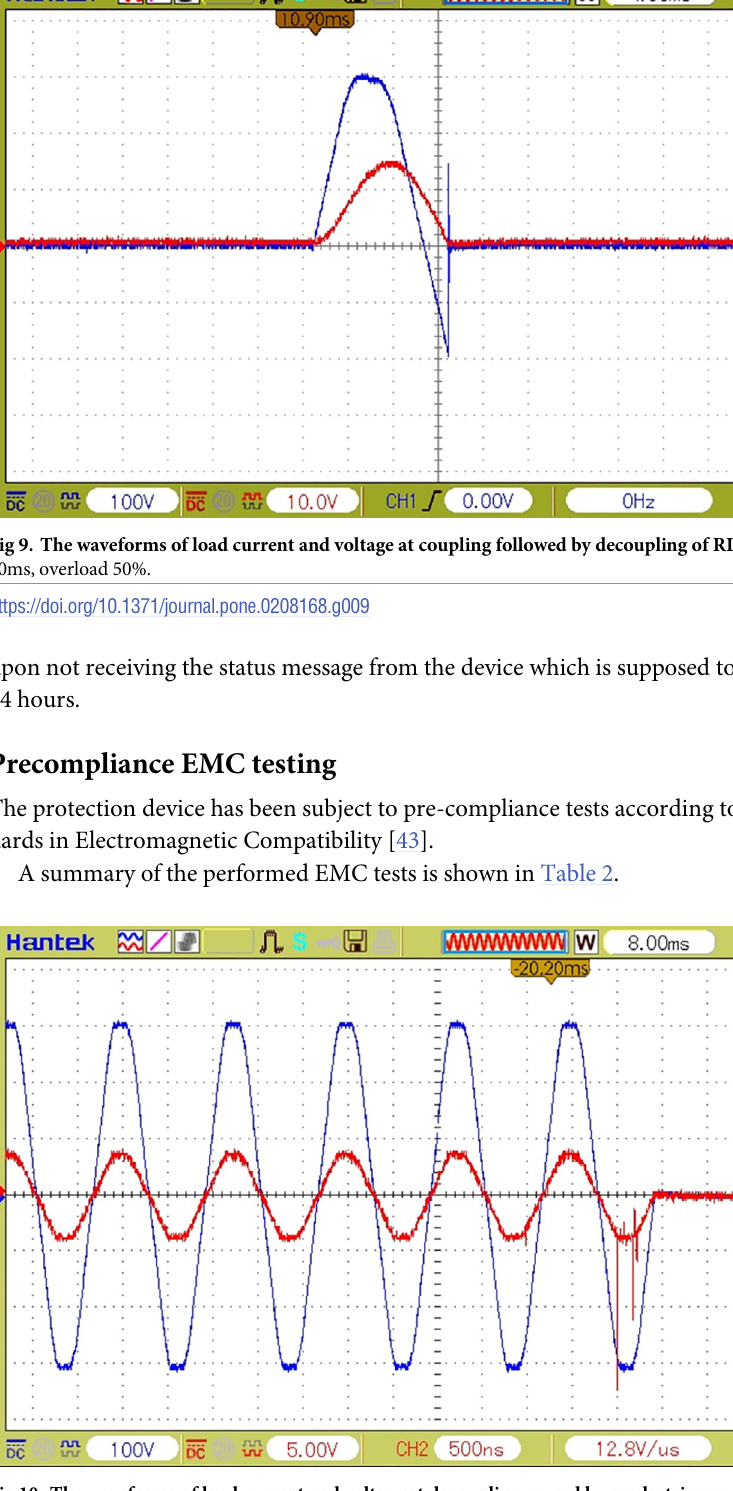
Fig 10. The waveforms of load current and voltage at decoupling caused by an electric arc detection on a resistive